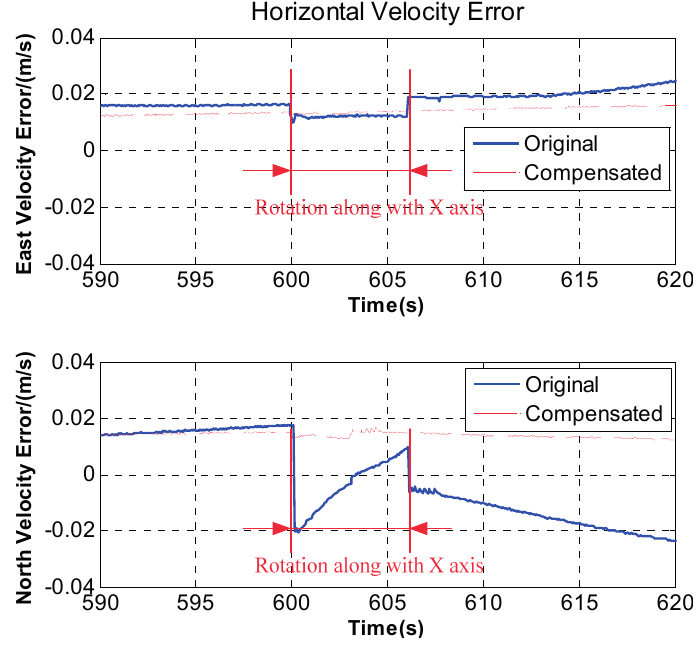
Figure 13. Comparison of original and compensated velocity stage